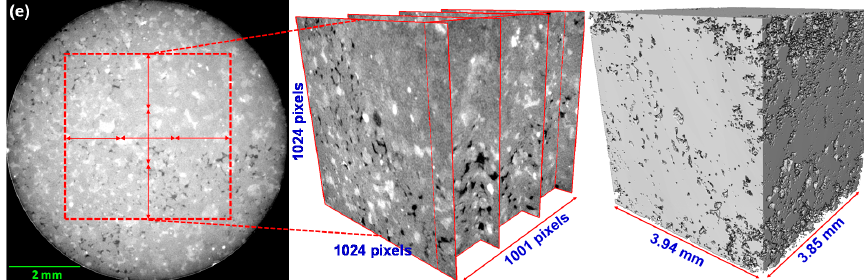
Figure 1. Typical 2D cross-sectional images of tested sandstones obtained by micro-CT imaging. In the resulting grayscale measurement plane, greater densities of attenuated pixels show brighter regions representing a dense solid. The regions are presented by 3D domains using a rendering process. ( a ) Boise sandstone ( b ) Berea sandstone ( c ) Buff Berea sandstone ( d ) Bandera sandstone ( e ) Linyi sandstone.